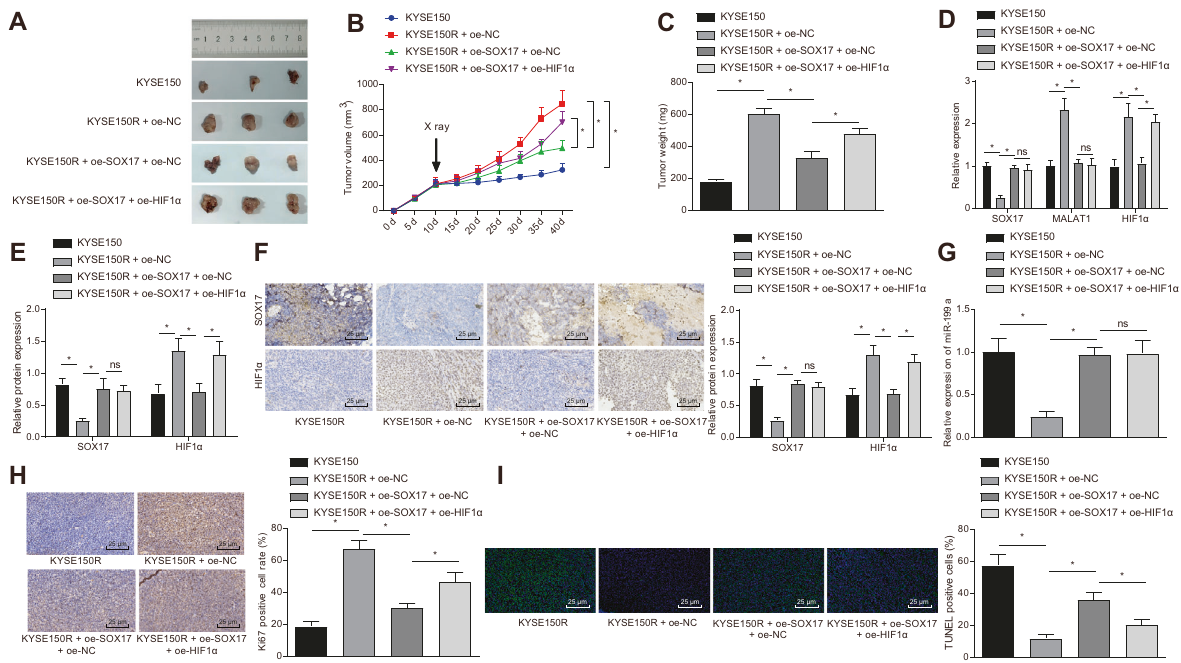
Fig. 7 Overexpression of SOX17 inhibited the irradiation tolerance of ESCC by mediating the MALAT1/miR-199a/HIF-1 α axis in vivo. Nude mice were divided into KYSE150, KYSE150 + oe-NC, KYSE150 + oe-SOX17 + oe-NC and KYSE150 + oe-SOX17 + oe-HIF1 α groups. A Representative images of tumors of nude. B Quantitative analysis for tumor volume of nude mice. C Quantitative analysis for tumor weight of nude mice. D SOX17 and HIF1 α mRNA expression in tumor tissues of mice as measured by qRT-PCR. E The protein expression of SOX17 and HIF1 α in tumor tissues of mice, as examined by Western blot analysis. F The protein expression of SOX17 and HIF1 α in tumor tissues of mice measured by immunohistochemistry G The miR-199a expression in tumor tissues of mice measured by qRT-PCR. H The expression of ki67 in tumor tissues of mice examined by immunohistochemistry. I Apoptosis of tumor cells in tumor tissues of mice measured by TUNEL assay. * p < 0.05 compared with the KYSE150 group, or the KYSE150 + oe-NC group. Measurement data were presented as mean ± standard deviation. Data of multiple groups were compared by one-way ANOVA with Tukey ’ s post-hoc test. Data of multiple groups at different time points were analyzed by two-way ANOVA, followed by Bonferroni post-hoc test. n = 12 for nude mice in each